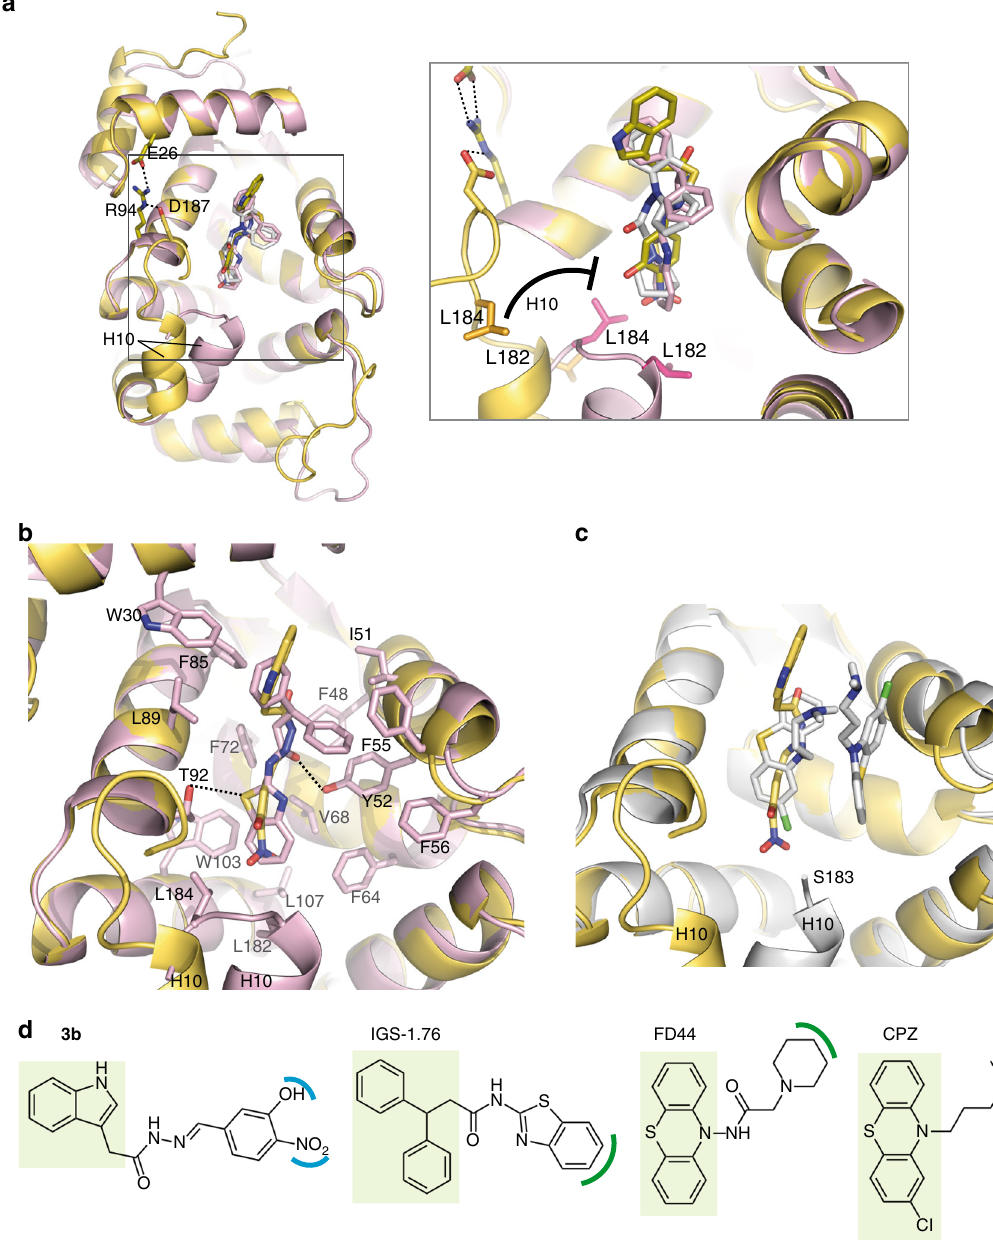
Fig. 8 Structural analysis of the NCS-1/Ric8a small molecule regulators. a , b Structural comparison of 3b with strong inhibitors. Superimposition of the structure of h NCS-1/ 3b complex (yellow ribbons/sticks) with that of d NCS-1/IGS-1.76 (pink ribbons/sticks) (PDB code 6epa) 19 . The structure of d NCS-1/ FD44 has also been superimposed 18 , but only the small compound is represented (white sticks). The grey square represents a rotated zoomed-in view to visualize the ligands ( 3b , IGS-1.76 and FD44) and helix H10. b The residues contacting IGS-1.76 are shown. Strong H-bonds of IGS-1.76 with Y52 and T92 are displayed with black dashed lines. c Structural comparison of 3b with a mild inhibitor. Superimposition of h NCS-1/ 3b complex (yellow) with d NCS-1/ CPZ (white) (PDB code 5g08) structures. Under the crystallization conditions, two different CPZ conformations were modeled. One of the conformations binds to the same site as compound 3b . However, CPZ hydrophobic tail is not ef fi cient enough in contacting helix H10 C-terminal end, which was found disordered in the crystal (from residue 184 to the end), and therefore the inhibition is mild 18 . d 2D structures of the regulatory molecules represented in ( a , c ). The aromatic region conserved in all PPI regulators is squared in light green. The region of FD44 and IGS-1.76 implicated in an ef fi cient interaction with helix H10 are highlighted in green. The 3b polar groups, sharing the same position, are highlighted in